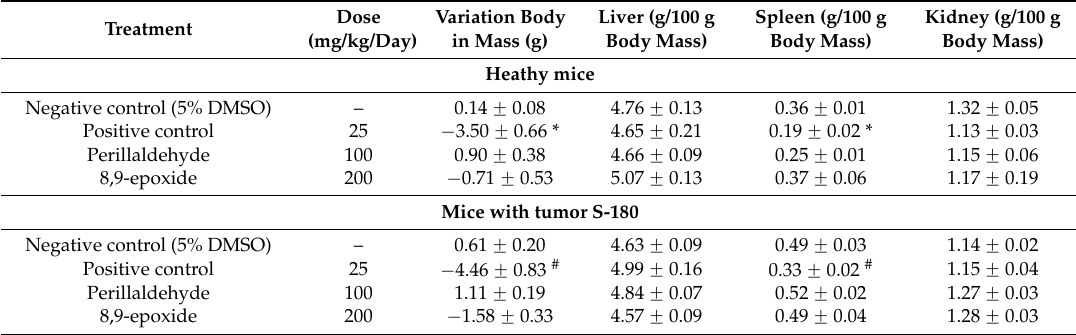
Table 1. The effect of perillaldehyde 8,9-epoxide on the body and organ weights of mice transplanted with S-180 tumor cells.